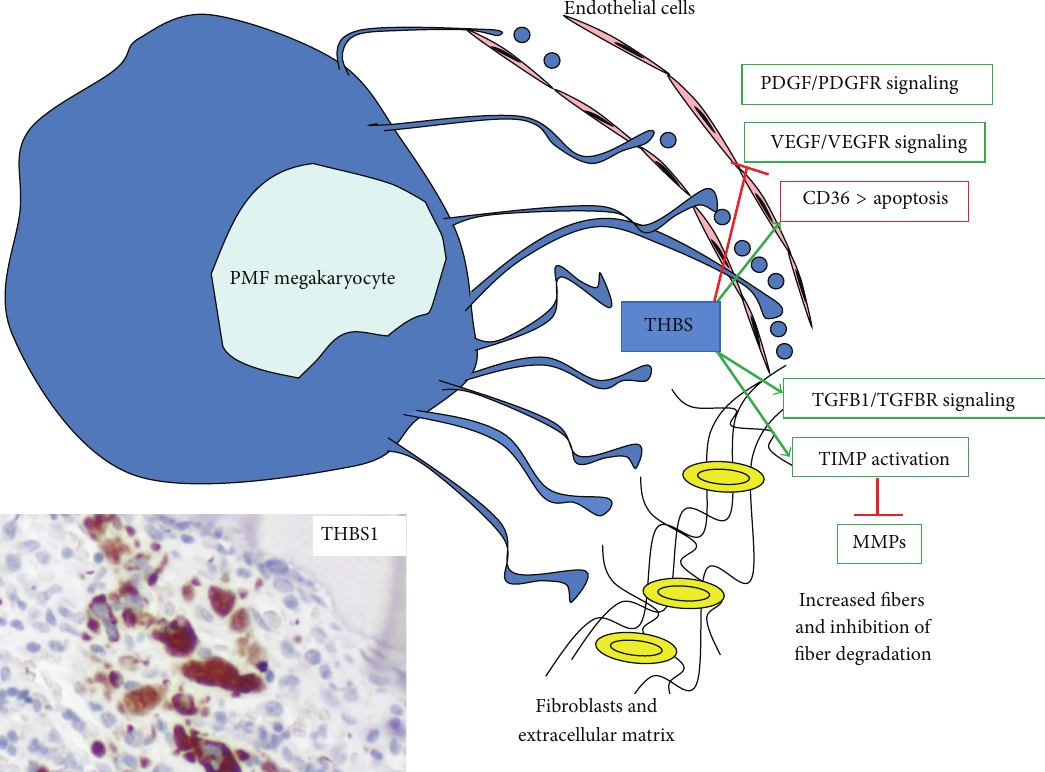
Figure 2: Role of THBS secreted by PMF megakaryocytes in angiogenesis and myelofibrosis development. Megakaryocytic THBS can lead to fibrosis via activation of TGF 𝛽 1 signaling and TIMPs but simultaneously inhibits angiogenesis via its receptor CD36 and inhibition of VEGF signaling. Nevertheless, myelofibrosis is associated with increased vascularization which could be mediated by PDGF signaling. The immunohistochemical image shows strong THBS expression in clustered PMF megakaryocytes and in small proplatelet depositions in situ .